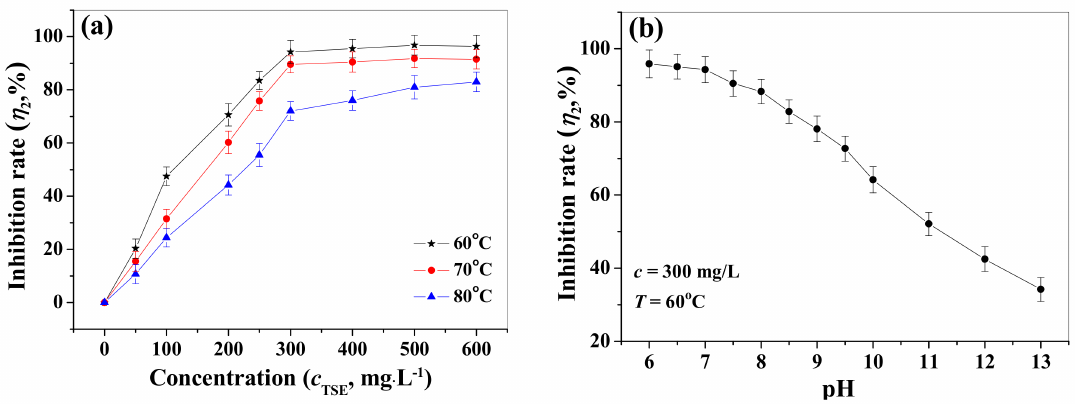
Figure 7. The e ff ects of temperature ( a ) and pH ( b ) on the scale inhibition rates of